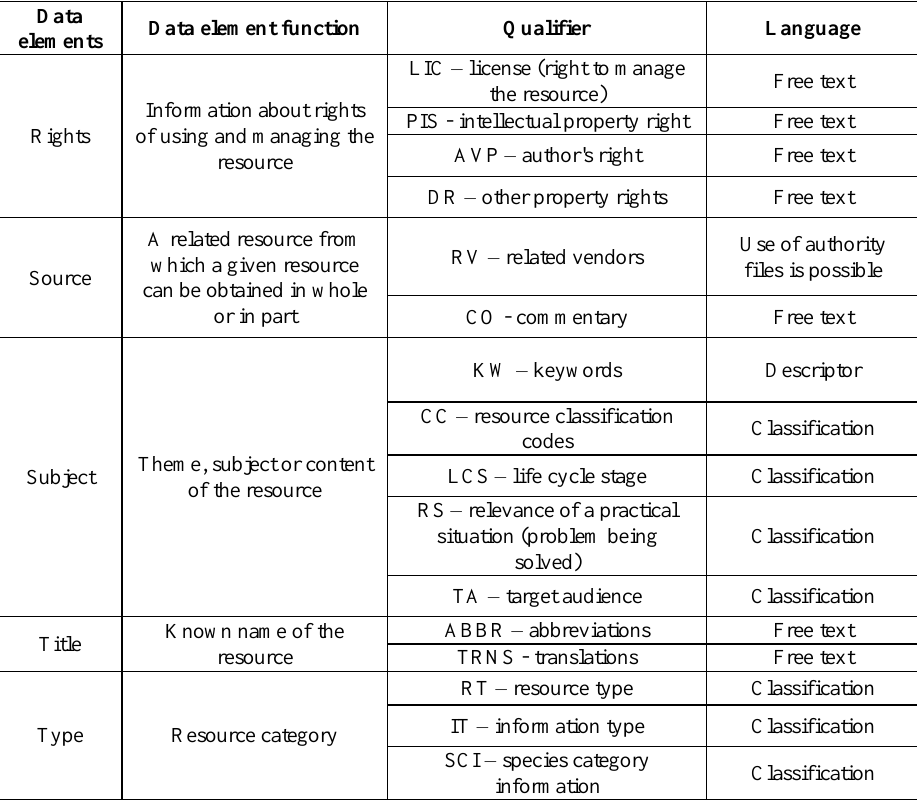
Table 2. (Continued) Metadatabase